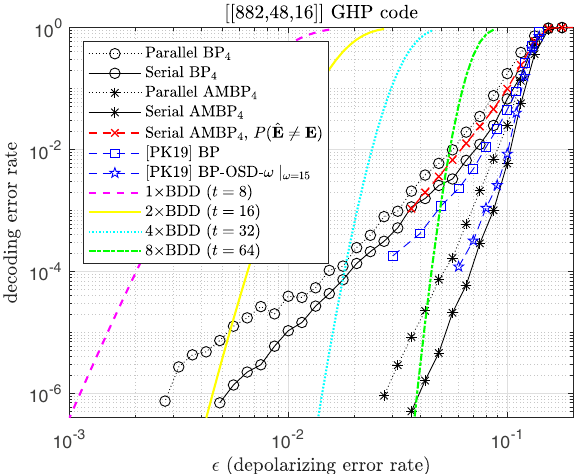
Fig. 3 The performance of the [[822, 48, 16]] GHP code. The maximum number of iteration is T max ¼ 32 . The decoding error rate for curve P ð ^ E ≠ E Þ is the classical block error rate, and for the other (non-BDD) curves, it is the logical error rate. The [PK19] curves are from ref. 33